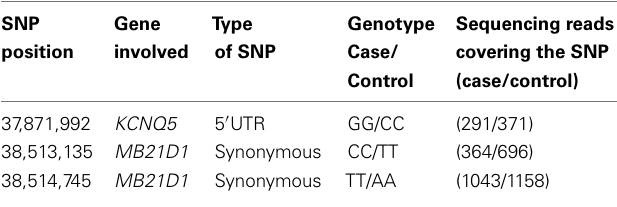
Table 2 | SNPs in protein coding regions and UTRs for which the case is homozygous.